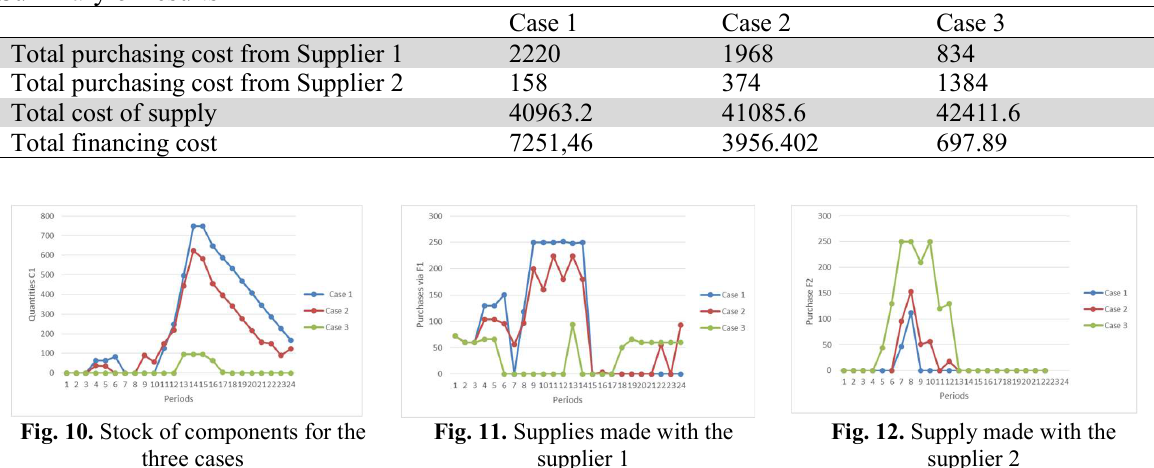
Fig. 10. Stock of components for the Fig. 11. Supplies made with the Fig. 12. Supply made with the